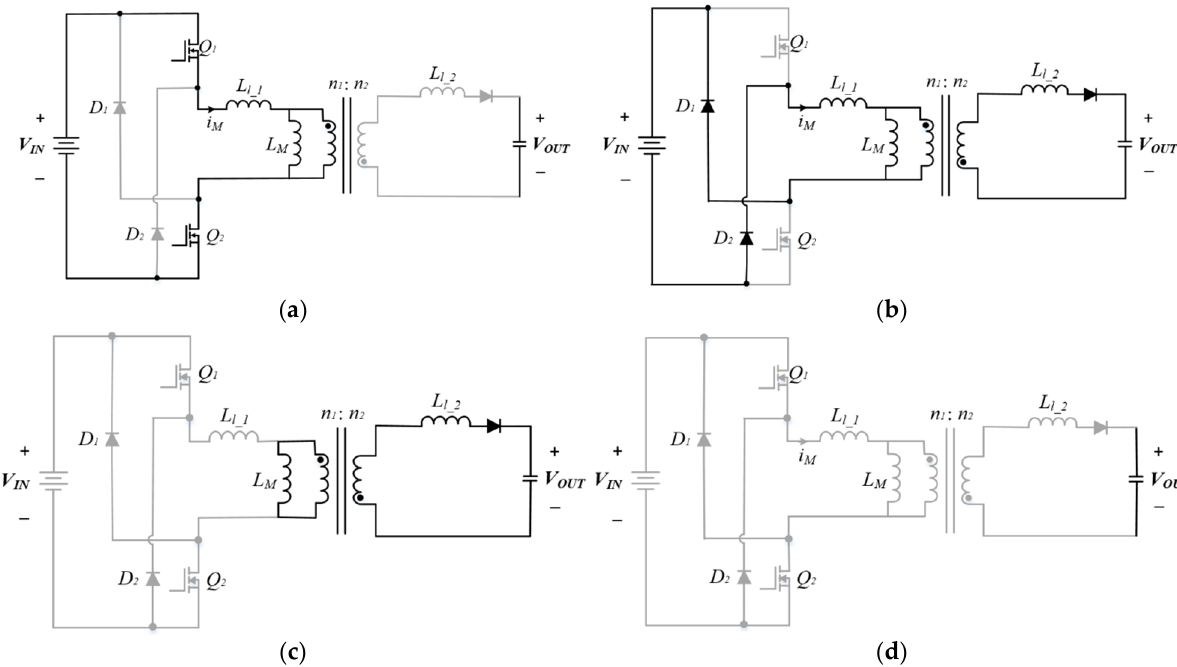
Figure 4. Operation modes of the two-switch flyback converter. ( a ) Q 1 , Q 2 on; ( b ) Q 1 , Q 2 off ( i M > 0); ( c ) Q 1 , Q 2 off ( i M = 0); ( d ) Q 1 , Q 2 off (all current in converter =